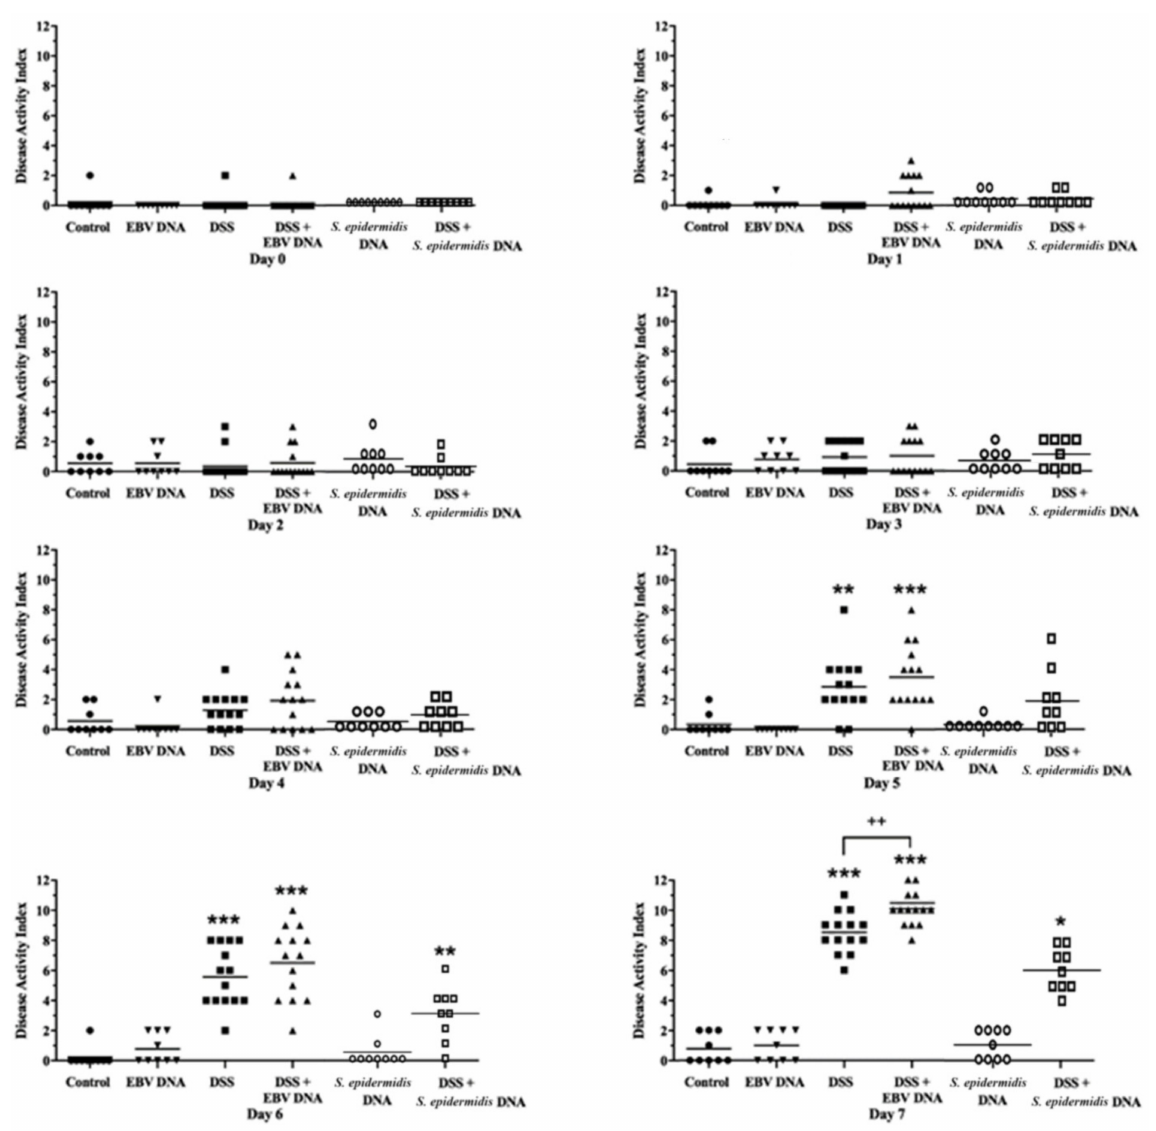
Figure 4. Disease activity index (DAI) scores in control and experimental mouse groups used to assess the effect of Epstein– Barr virus (EBV) DNA on colitis severity in C57BL/6J mice. C57BL/6J mice ( n = 9–14 per group) received either 1.5% dextran sodium sulfate (DSS)-containing or regular drinking water for 7 days. Three DSS-treated groups were then rectally administered sterile water, Epstein–Barr virus DNA in sterile water or S. epidermidis DNA in sterile water on day 3. The other normal drinking water-fed groups were included as controls and also received sterile water, EBV DNA or S. epidermidis DNA by rectal gavage on day 3. The DAI was determined daily as a composite measure of the scores of body weight loss, stool consistency and fecal blood. Individual mouse and average DAIs per group are indicated. * p < 0.05, ** p < 0.01, *** p < 0.001, compared to the control group on the same day; ++ p < 0.01, compared to the DSS group on the same